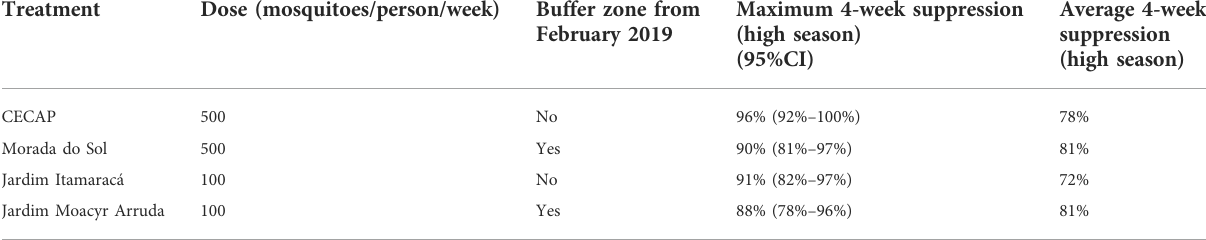
TABLE4The maximumandaverage suppression valuescalculatedacrossthehigh mosquitoseason inthefourtreatedareas inIndaiatuba.Maximum 4-weeksuppression ishighestsuppressionobservedwhenmeasuredasa4-weekrollingaverage, with95%con fi denceintervalscalculatedusing the bootstrap method described above. The average suppression across the whole season is calculated as the mean of all 4-week rolling averages, across the high mosquito season.